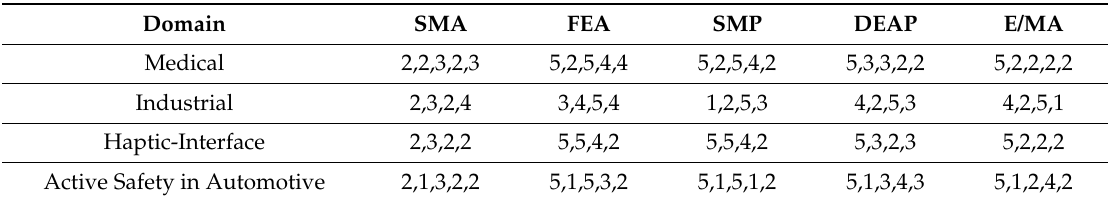
Table 7. The most important combinations.